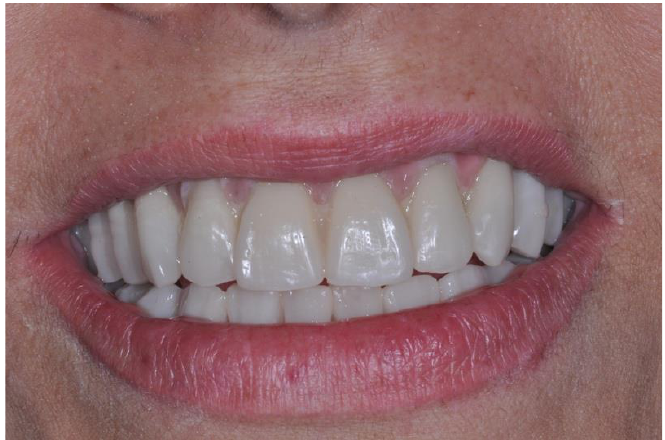
Figure 2. Patient smile at 1 year after loading.